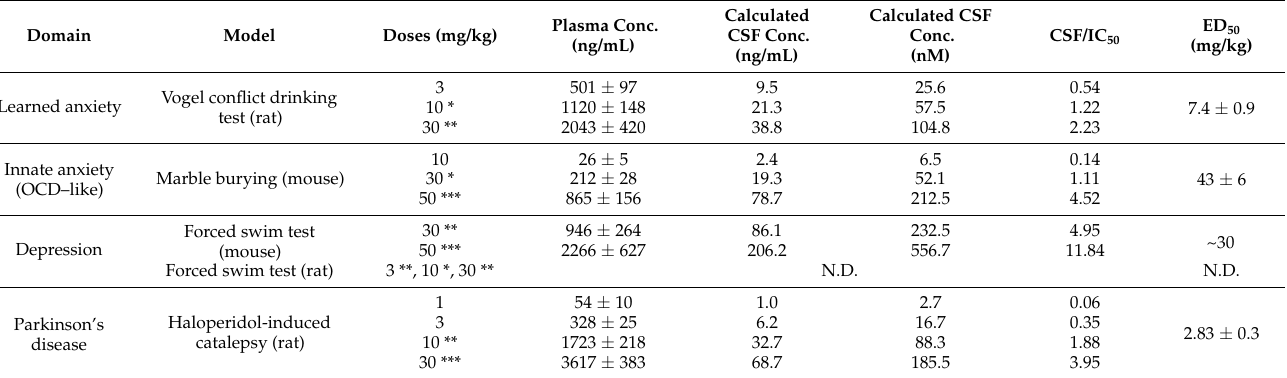
Table 1. Pharmacokinetic-pharmacodynamic relationship between plasma and CSF concentrations of dipraglurant and its efficacy in in vivo models. Pharmacological effect per dose indicated as * p < 0.05, ** p < 0.01, *** p <